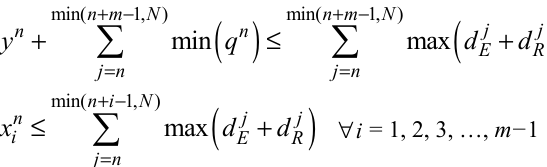
Inventory State at n=1